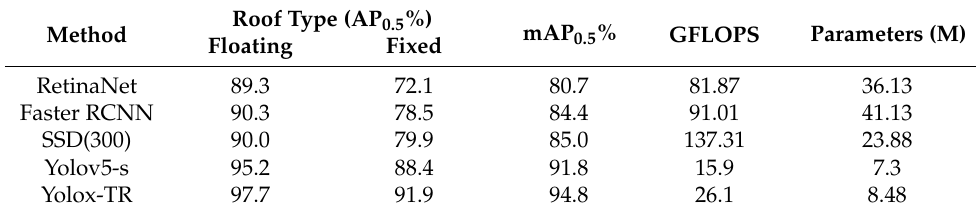
Table 4. Comparative results of different detectors.